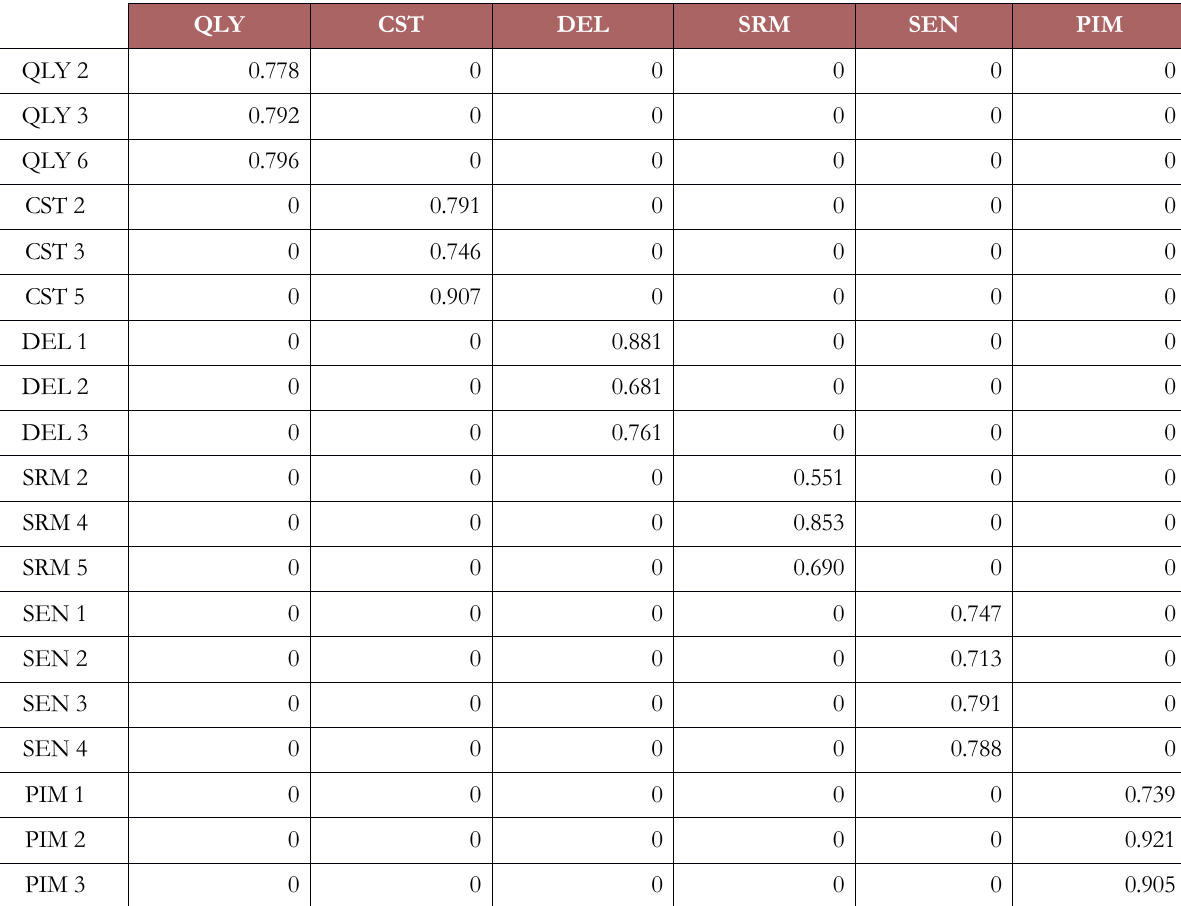
Table 6. Factor Loadings after